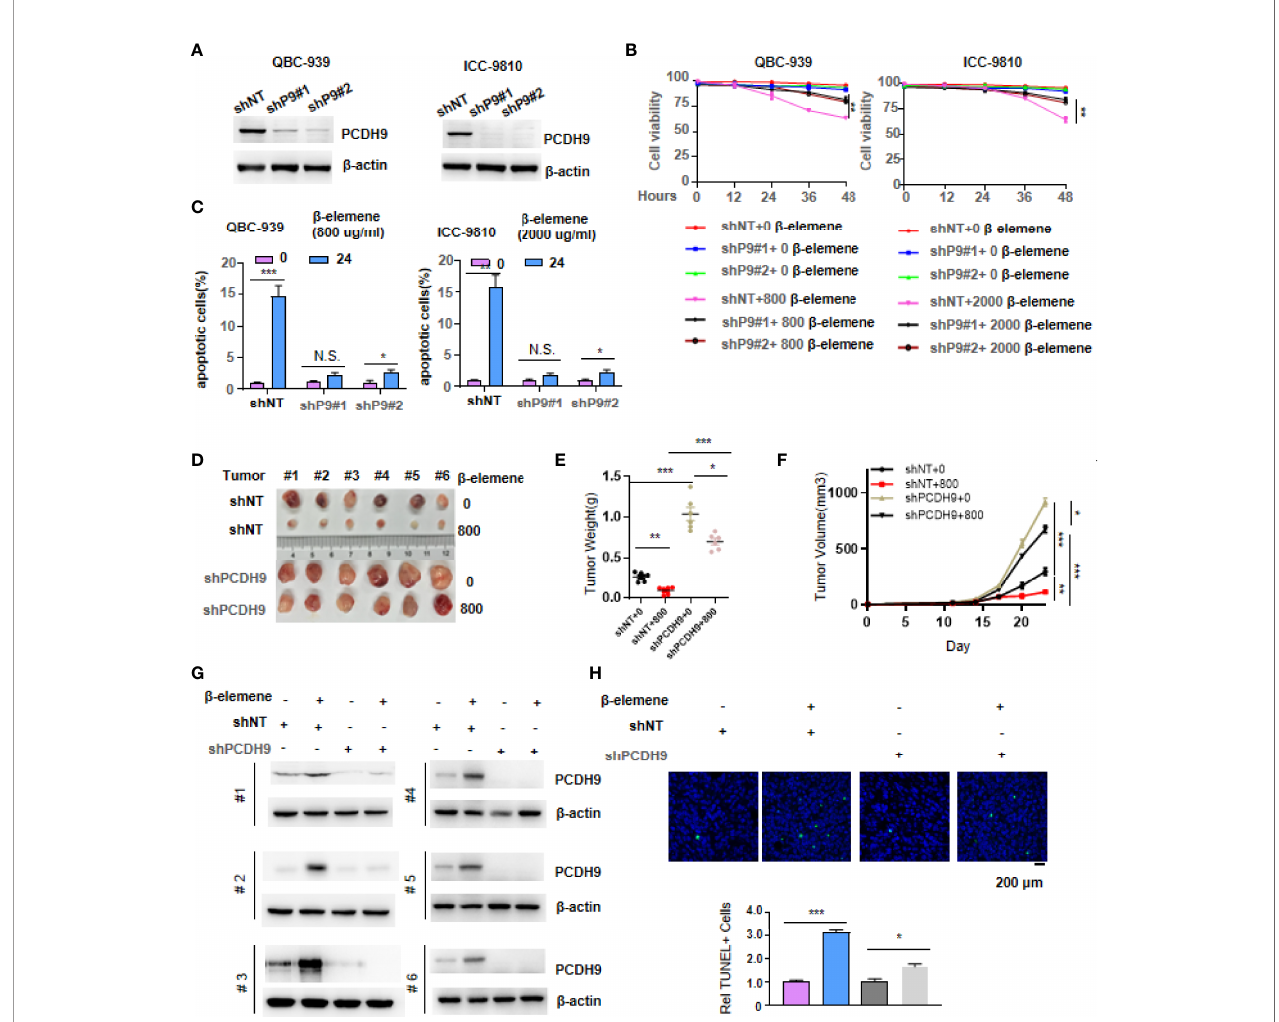
FIGURE 4 | PCDH9 depletion impaired the effect of b -elemene on cholangiocarcinoma (CCA) cells. (A) PCDH9 was stably depleted by two independent shRNAs, and Western blotting tested the ef fi ciency of knocking down PCDH9. (B) Cell viability of both genetically manipulated QBC-939 and ICC-9810 cells was measured by Trypan blue stain assay following b -elemene treatment at indicated concentrations and time points. ** p < 0.01. (C) Apoptotic assay of both genetically manipulated QBC-939 and ICC-9810 cells was performed by propidium iodide (PI)/annexin V double staining kit following b -elemene treatment at indicated concentrations and time points. * p < 0.05; ** p < 0.01; ***p < 0.001; NS, not signi fi cant. (D – F) The stable cell lines constructed in panel A were transplanted into the left groin of nude mice (n = 6, each group). Solid tumors were dissected and imaged at the end of the experiment (D) . Tumor weight was measured, *p <